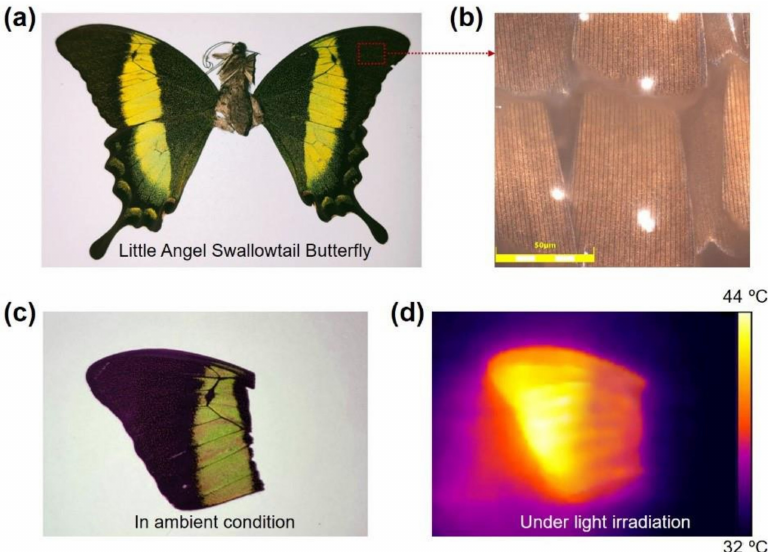
Figure 2. ( a ) Photograph of a butterfly. ( b ) CLSM images of the butterfly wings. ( c ) Photography of a fragment of butterfly wings. ( d ) Photothermal image of the fragment under light